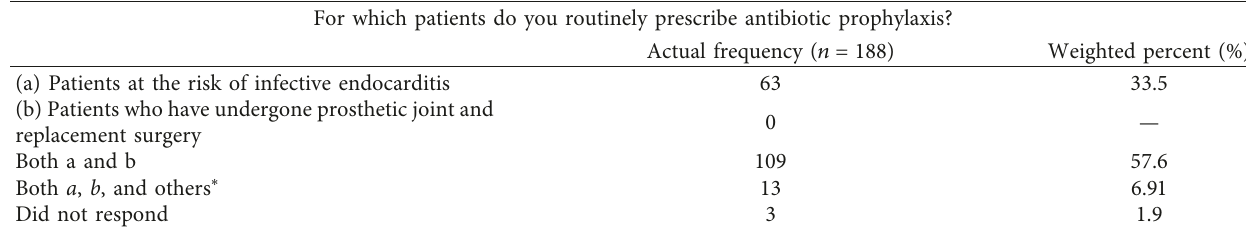
Table 6: Use of antibiotic prophylaxis in general dental practice.